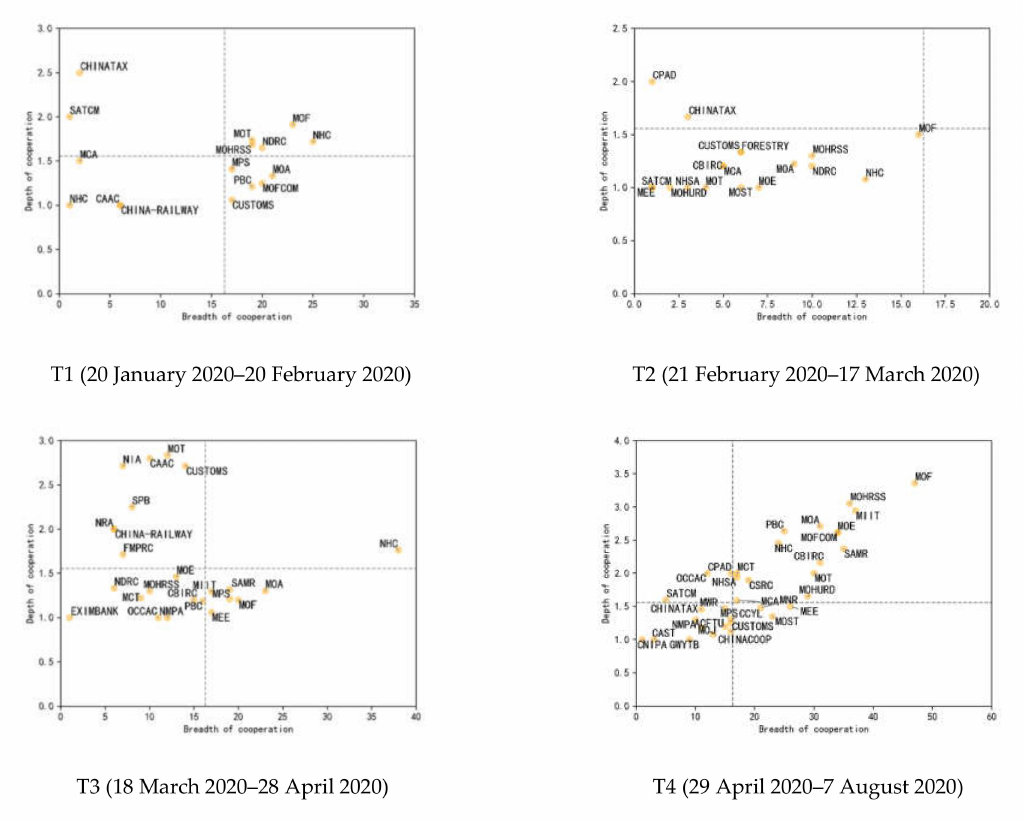
Figure 3. Two-dimensional “breadth–depth”